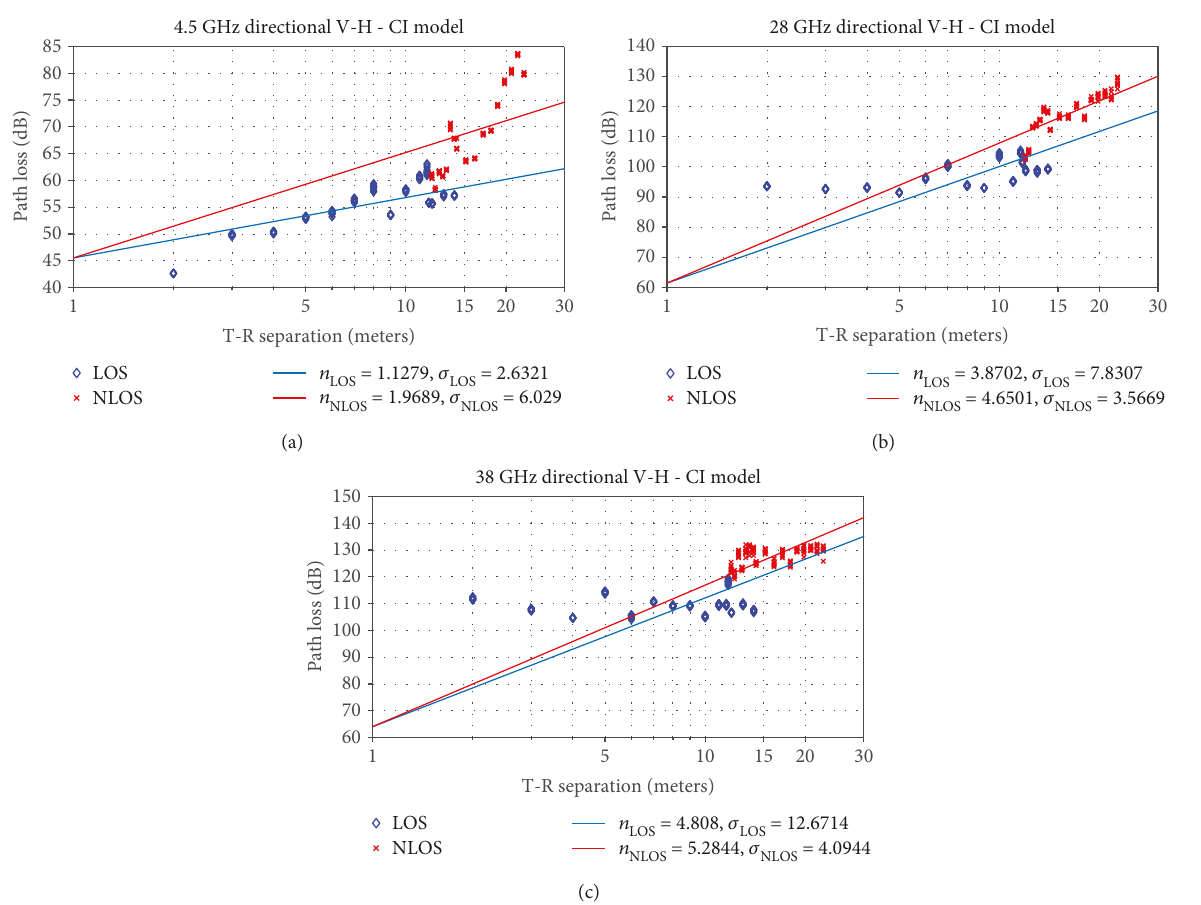
Figure 3: Directional V-H CI path loss model for LOS and NLOS (a) 4.5GHz, (b) 28GHz, and (c)